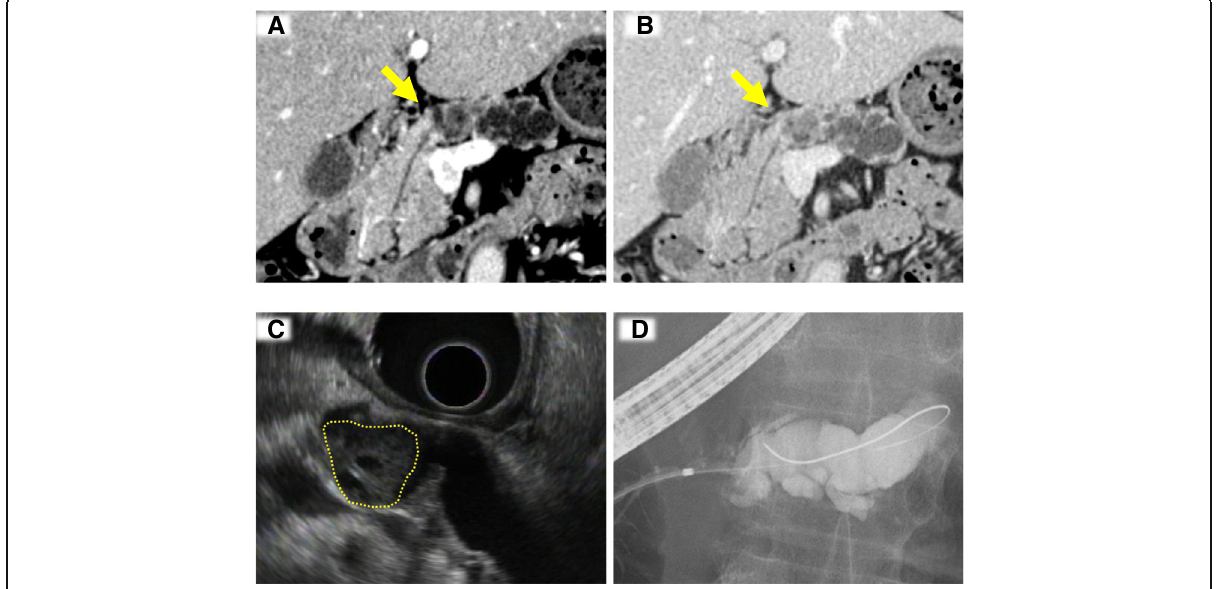
Fig. 1 Radiologic findings. a , b Dynamic computed tomography. A solid mass in the pancreatic body (indicated by an arrow) is enhanced at the arterial phase ( a ), and the enhancement is prolonged at the delayed phase ( b ). c Endoscopic ultrasonography. A tumor developed in the main pancreatic duct (a dotted circle). d Endoscopic retrograde cholangiopancreatography. The main pancreatic duct of the distal portion is markedly dilated because the solid tumor obstructs fluid